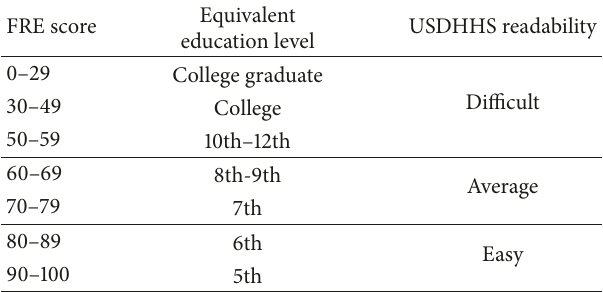
Table 3: Flesch reading ease scores with equivalent US education level and USDHHS readability rating.